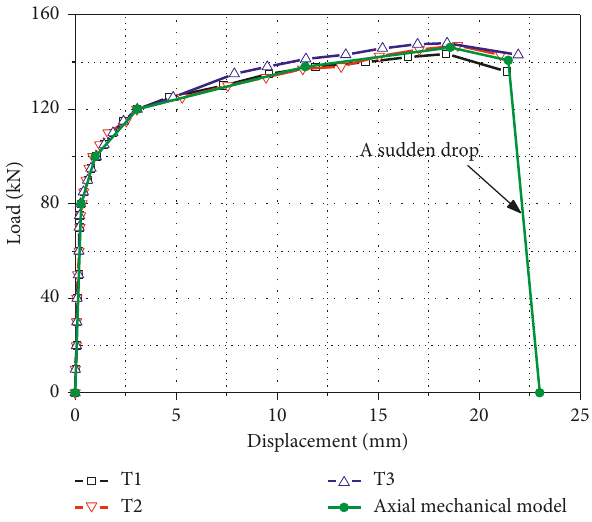
Figure 7: Axial load versus displacement